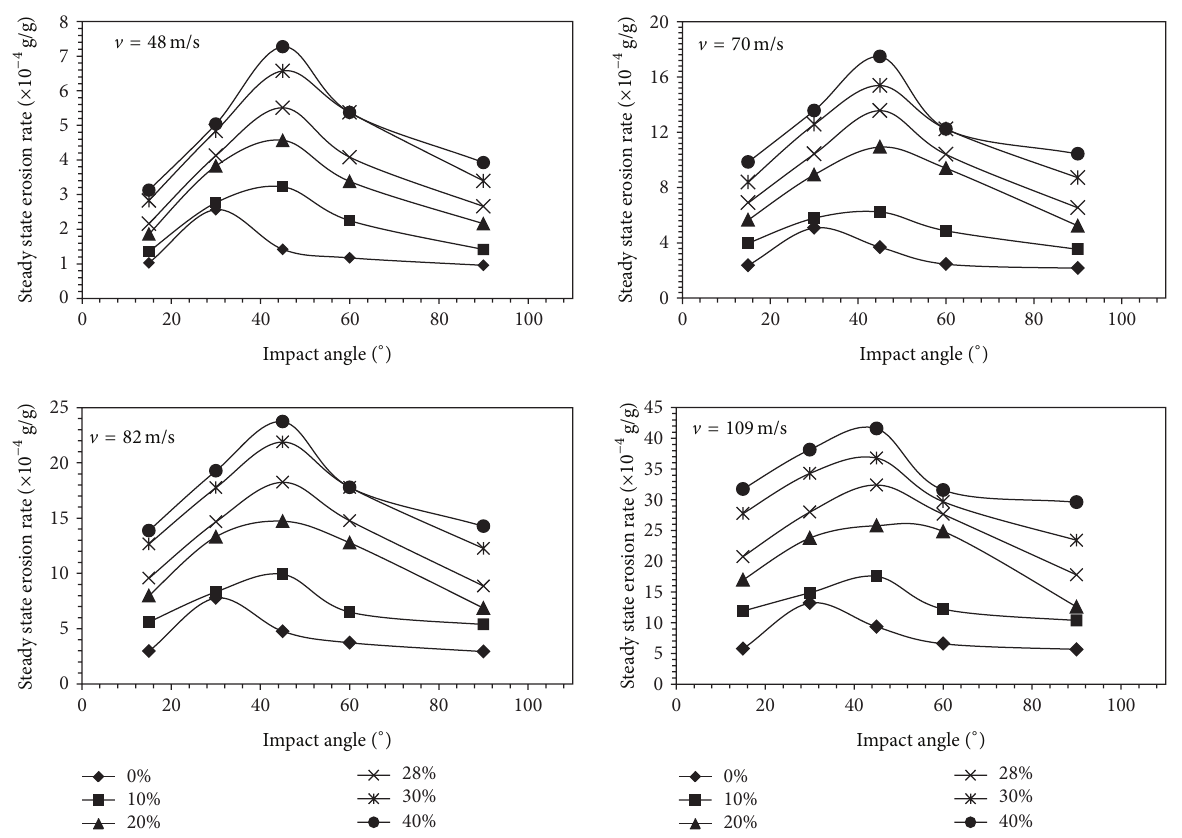
Figure 3: Influence of impingement angle ( 𝛼 ) on steady-state erosion rate of PVA/DPL